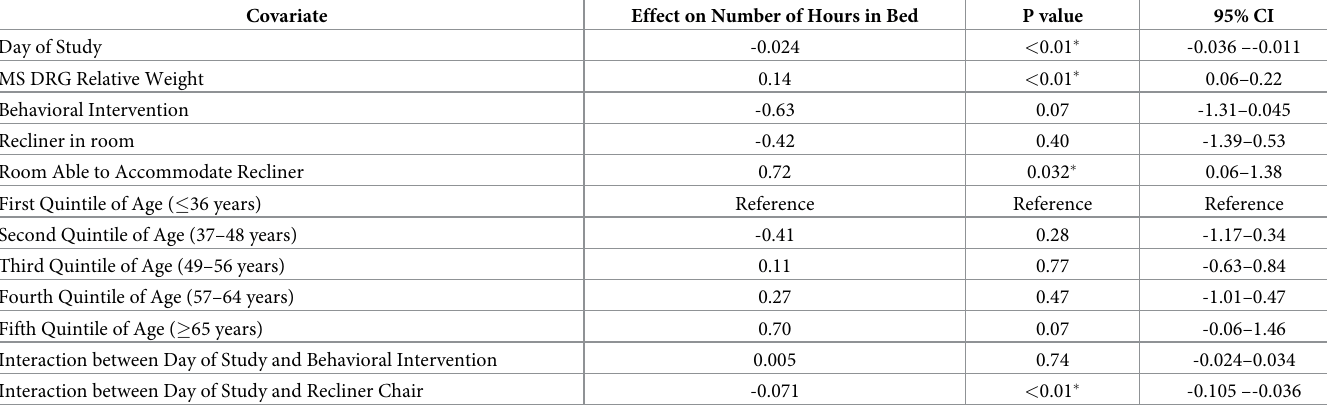
Table 4. Multivariate analysis of factors associated with time spent in bed (N =